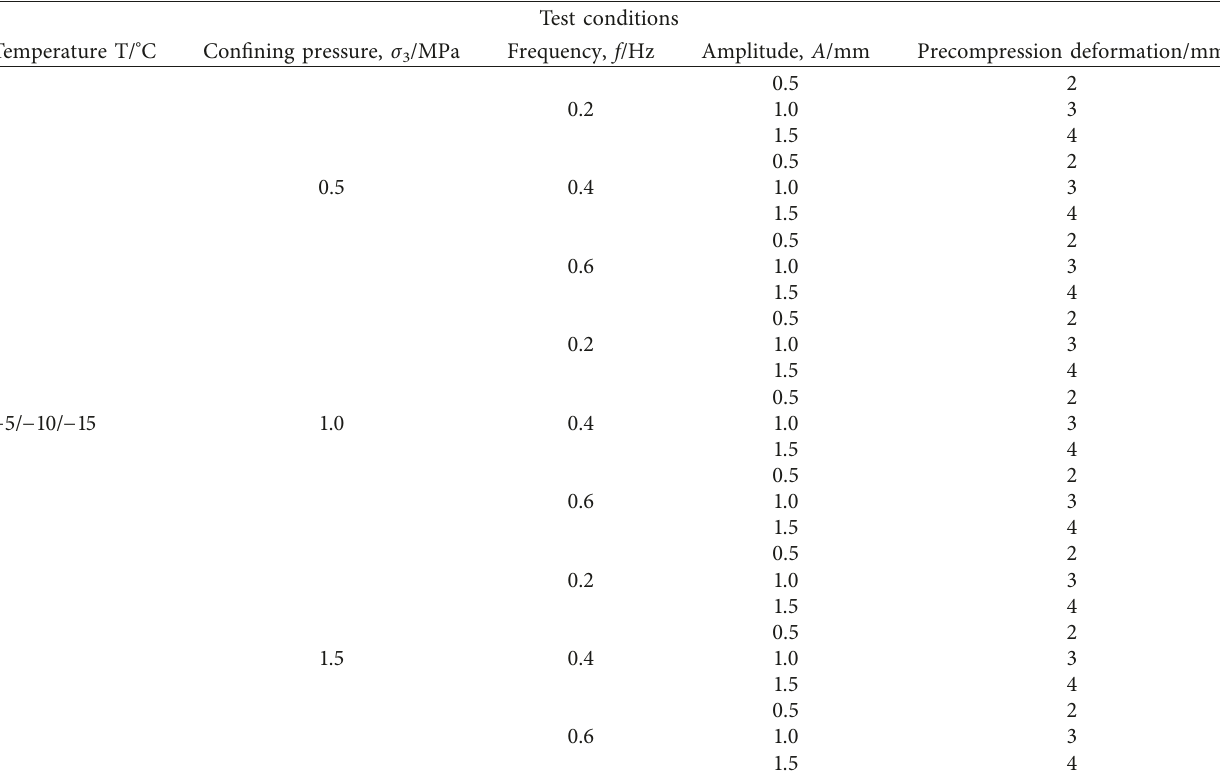
Table 2: Dynamic triaxial shear test of frozen clay ( − 5/ − 10/ − 15 °